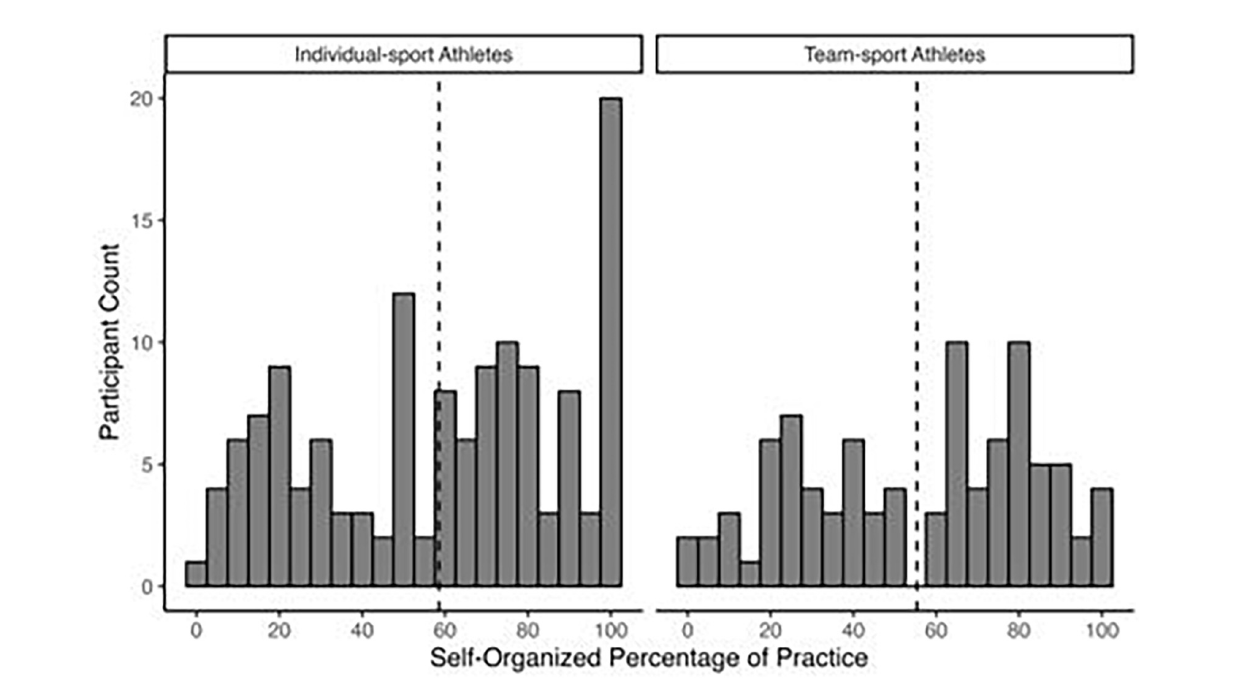
FIGURE3 Distributions of perceived self-organized practice time from 0 to 100% of total sport training for individual-sport athletes (left) and team-sport (right) athletes, from Bain et al. (2020). Each bar represents a bin of 5 percentage points in width. Dotted lines indicate the mean percentage of perceived self-organized practice time by sport